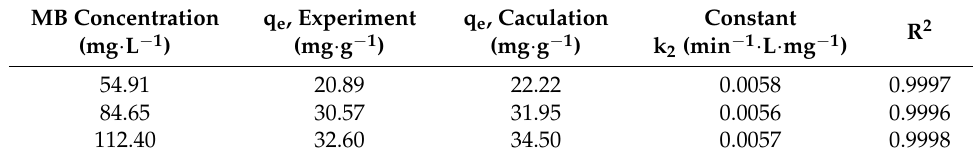
Table 7. Parameter values of pseudo-second-order adsorption kinetic equation.